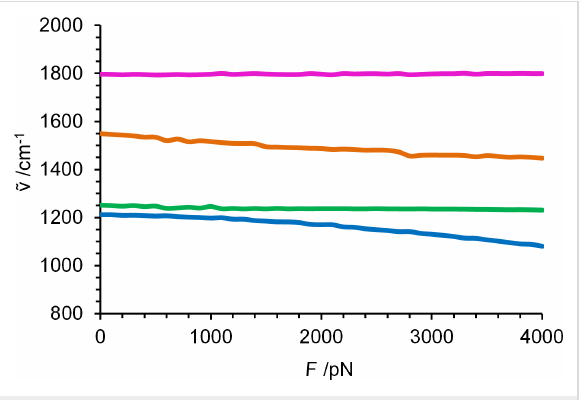
Figure 2: Intensities in fingerprint region of the infrared spectrum ob- tained for N -propylpropanamide. Spectral lines are broadened with a Lorentzian (34 cm − 1 at FWHM) and summed up, yielding the spec- trum of a stretched molecule.